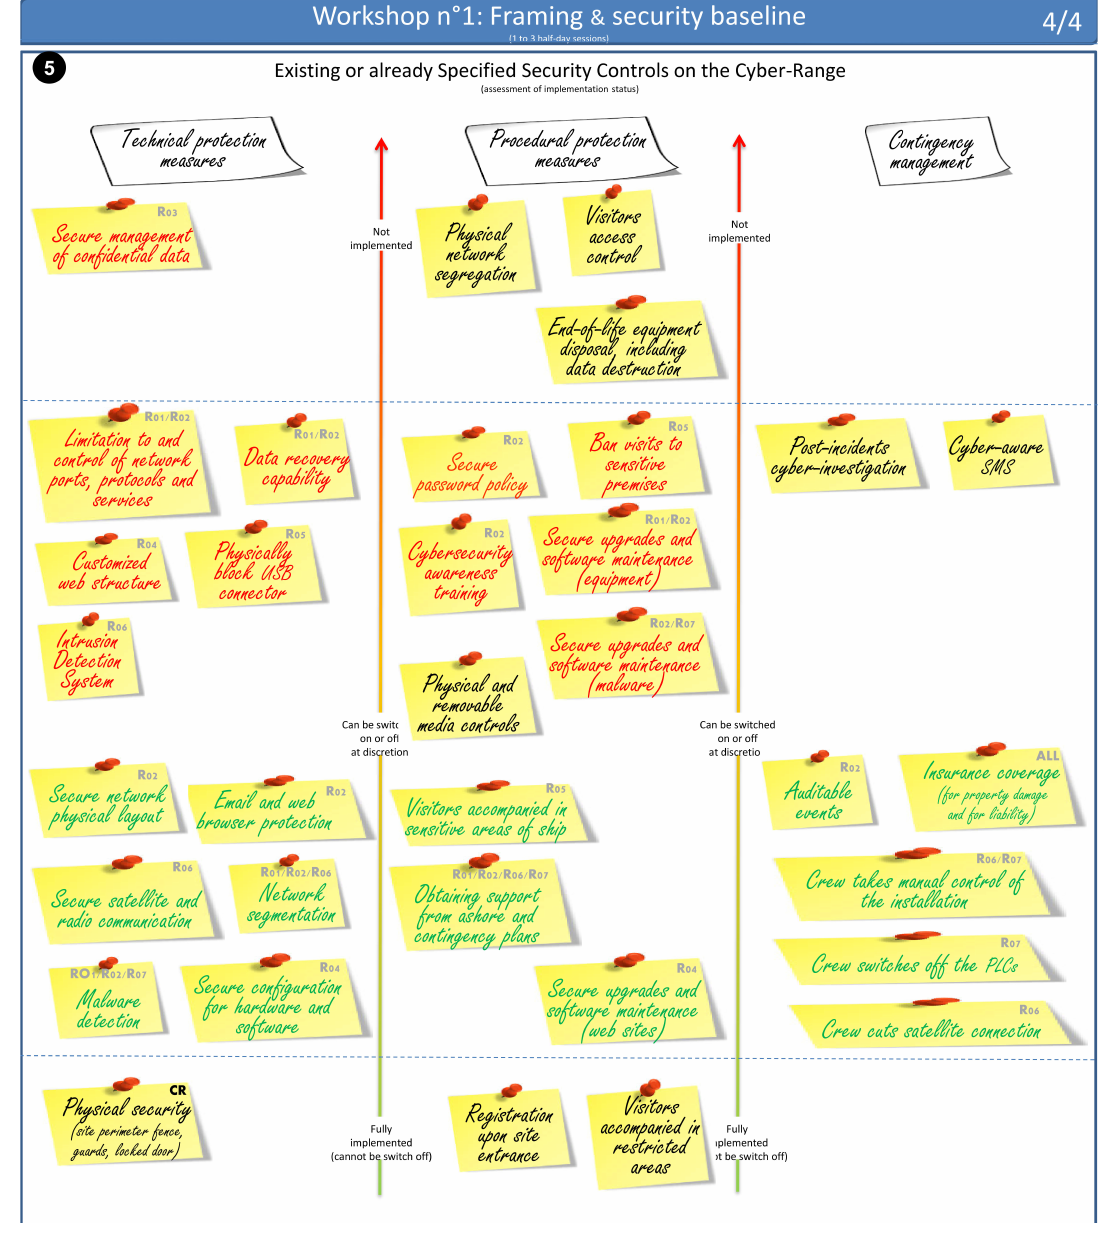
Figure 7. Naval use case—security